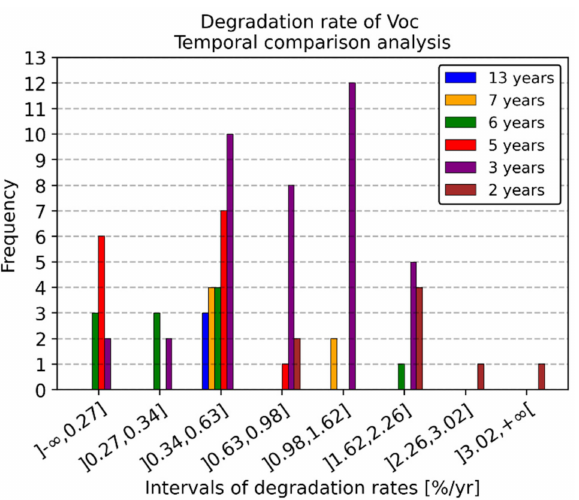
Figure 9. Temporal analysis of the degradation rate of the open-circuit voltage. Modules operating